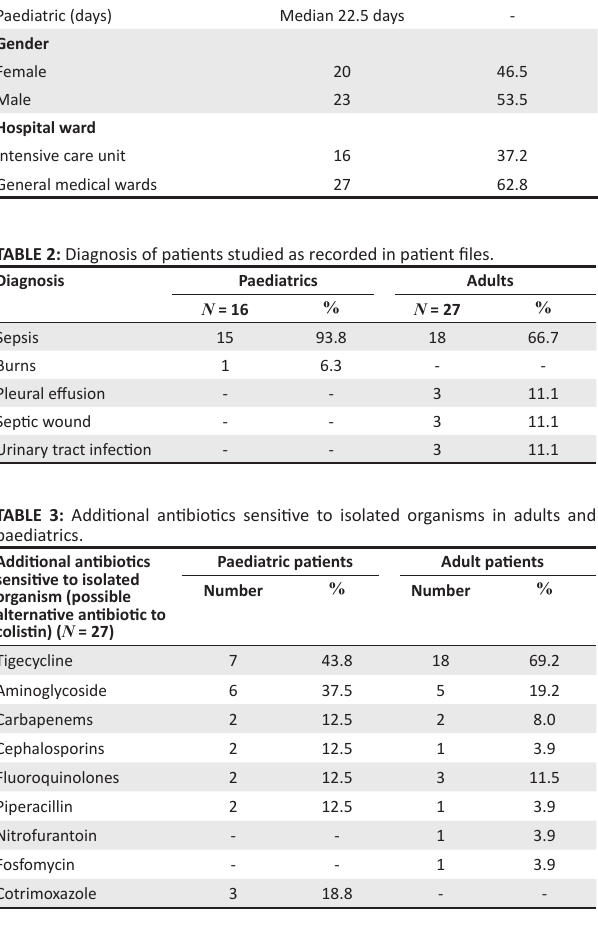
TABLE 4: Compliance with colistin dosing recommendations in paediatric and adult patients.